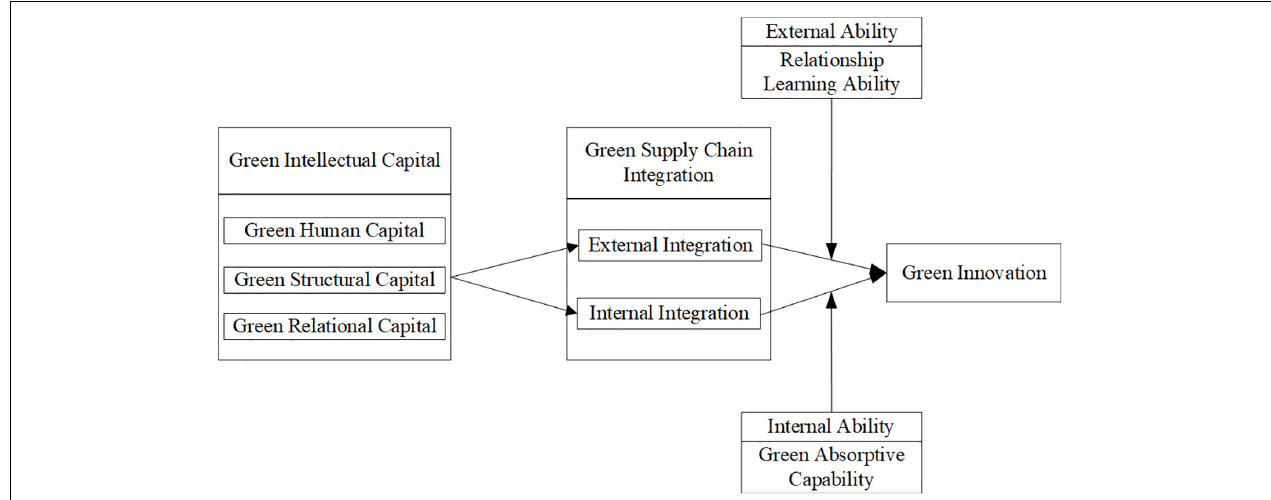
FIGURE 1 | Framework of the